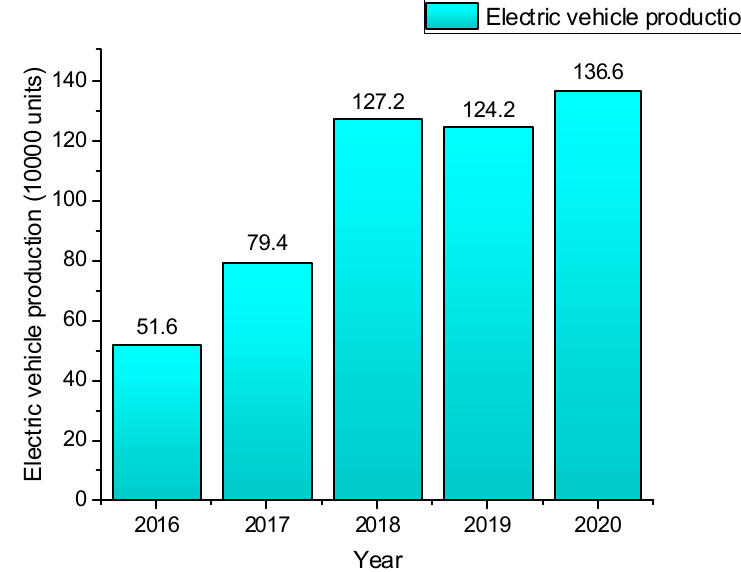
Figure 1. China’s electric vehicle output from 2016 to 2020.